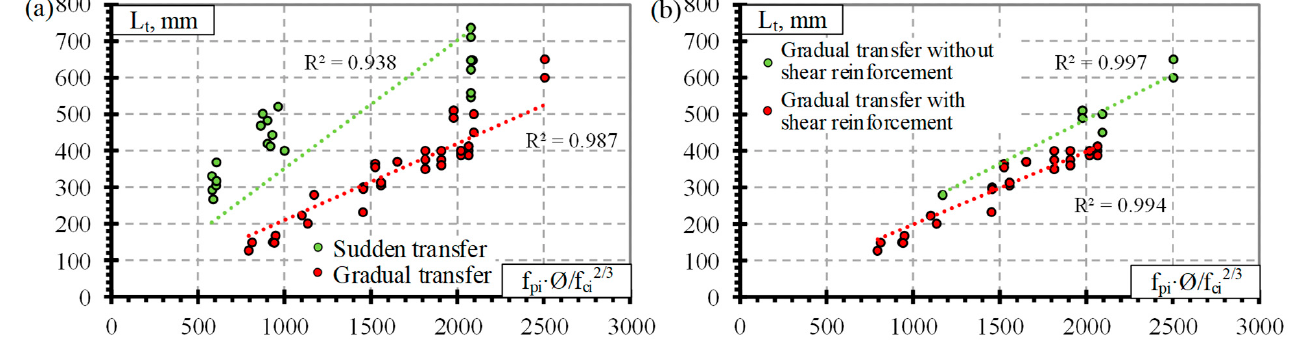
: ( a ) effect of types ci f / f ⋅∅ : ( a ) effect of pi ci